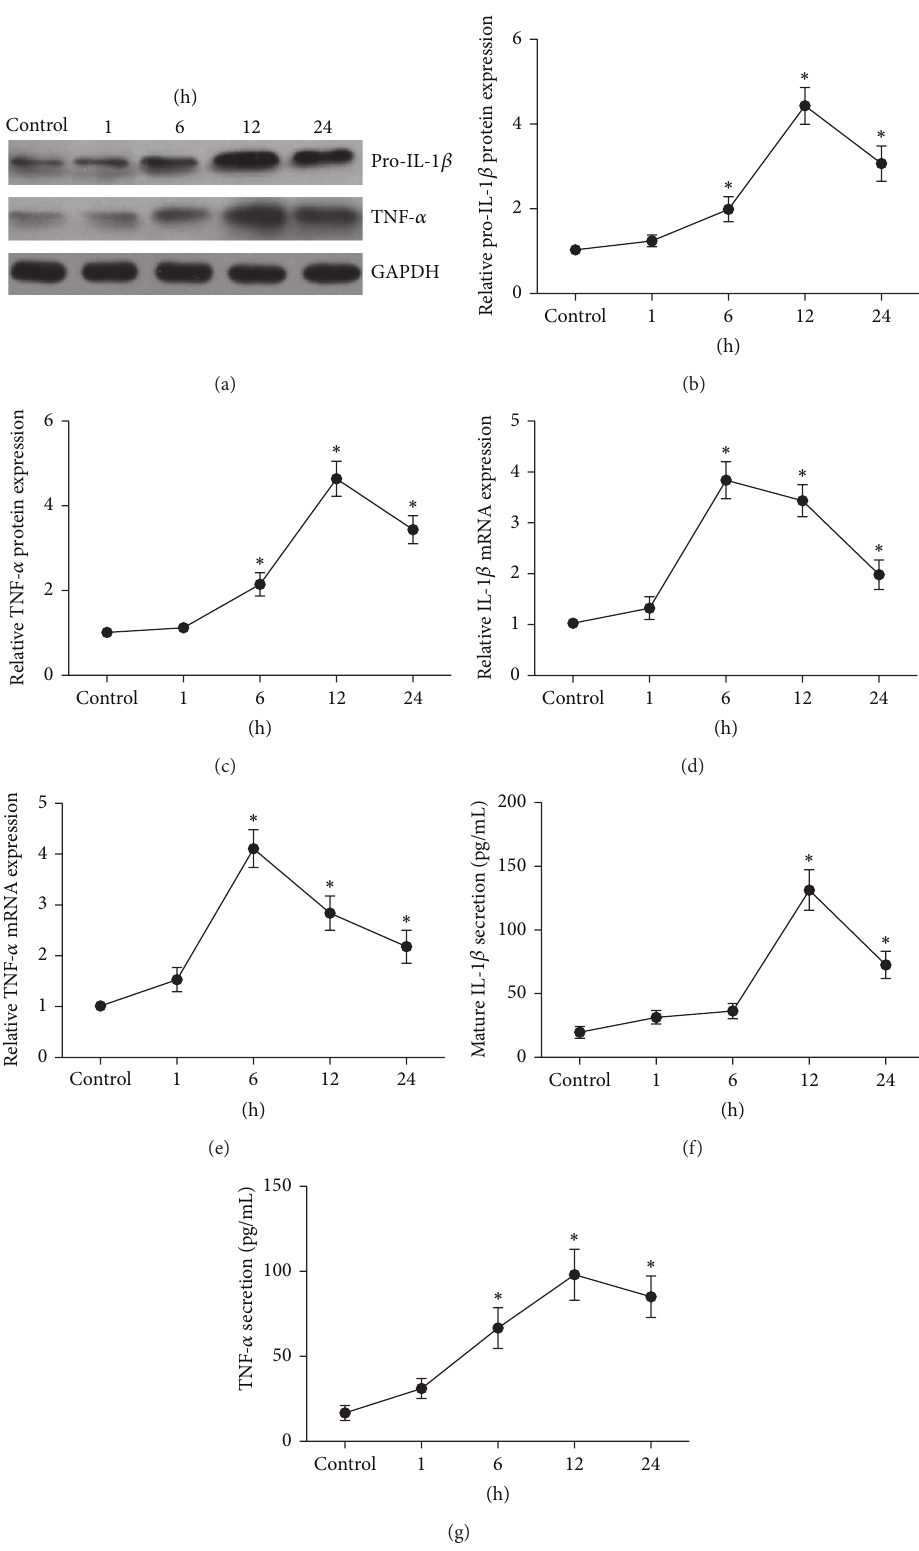
Figure 3: LPS induced IL-1 𝛽 and TNF- 𝛼 expression in SFs in a time-dependent manner. SFs were treated with LPS (100ng/mL) for 1, 6, 12, 24h, cellular lysates were subjected to Western blotting to detect the protein expression of pro-IL-1 𝛽 and TNF- 𝛼 (a), and the relative expression of pro-IL-1 𝛽 (b) and TNF- 𝛼 (c) was calculated. The expression of IL-1 𝛽 (d) and TNF- 𝛼 (e) mRNA was determined by real time quantitative PCR. Mature IL-1 𝛽 (f) and TNF- 𝛼 (g) proteins secreted into the cell culture media were measured by ELISA. Data shows all the values from independent samples of 𝑛 = 3 , ∗ 𝑃 < 0.05 versus nonstimulated